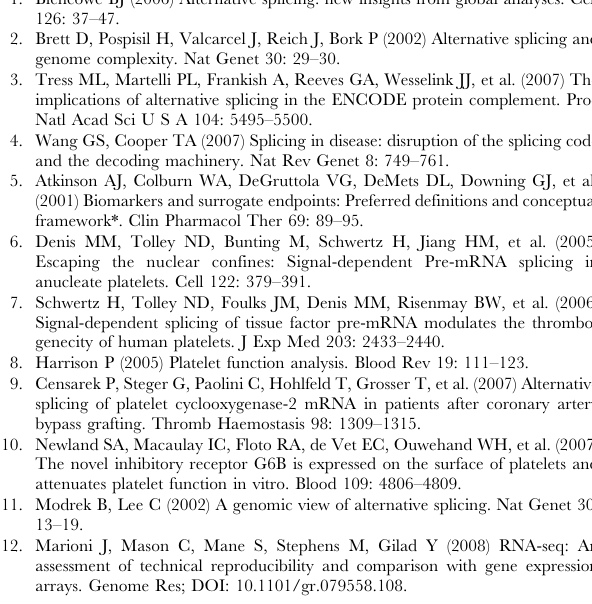
Table S1 Characteristics of the contents and constraints applied to create the species-specific SkipE databases.